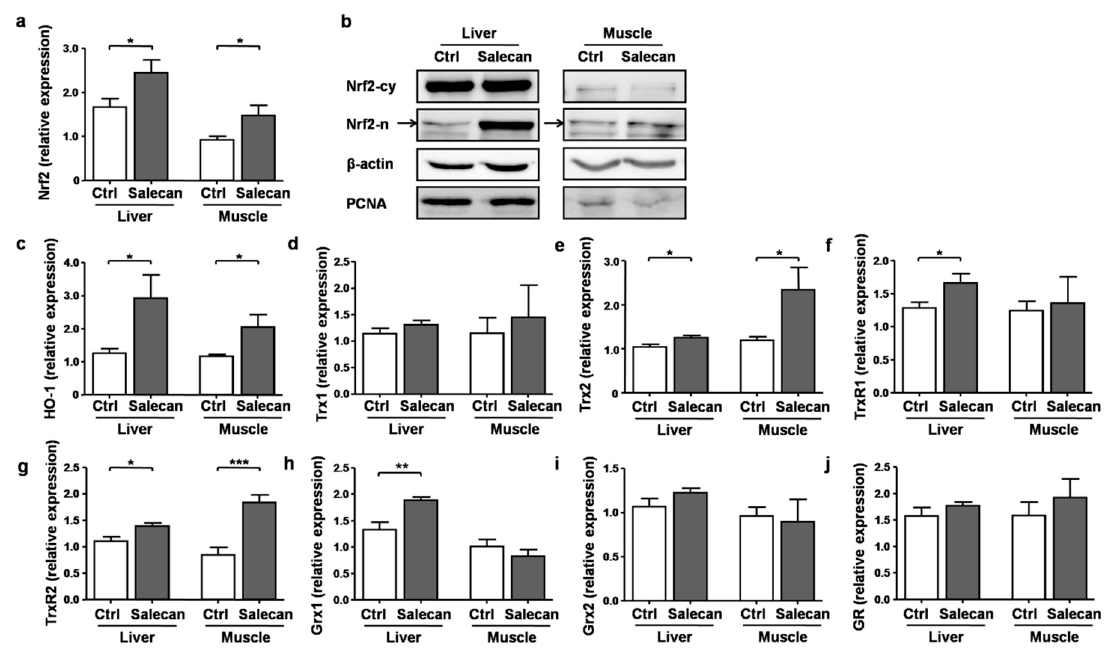
Figure 7. The mRNA and protein levels of ( a , b ) Nrf2; mRNA expression levels of ( c ) HO-1, ( d ) Trx1, ( e ) Trx2, ( f ) TrxR1, ( g ) TrxR2, ( h ) Grx1, ( i ) Grx2, and ( j ) GR in the liver and muscle of mice from the